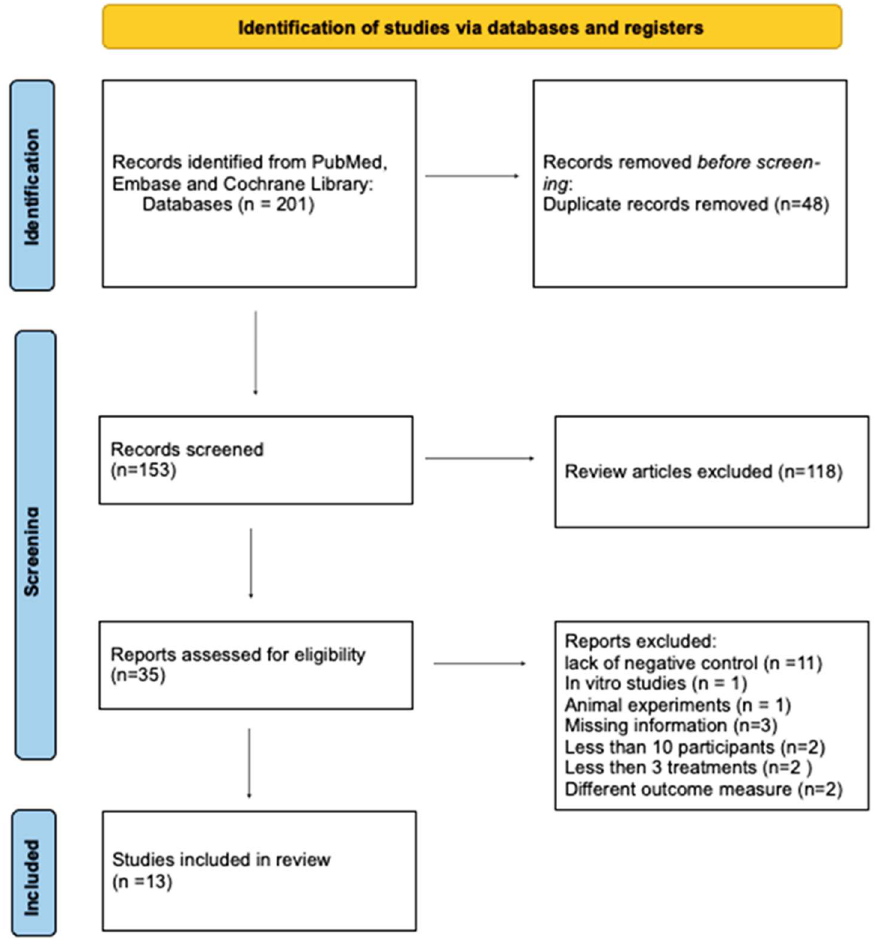
Figure 3. Identification of studies via databases and registers.